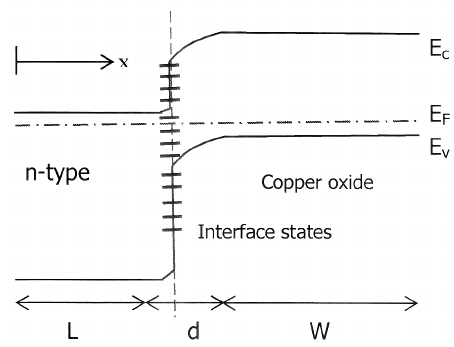
Figure 2. Schematic energy band diagram for heterojunction solar cell of copper oxide and an n-type semiconductor. Interface states are represented by - .